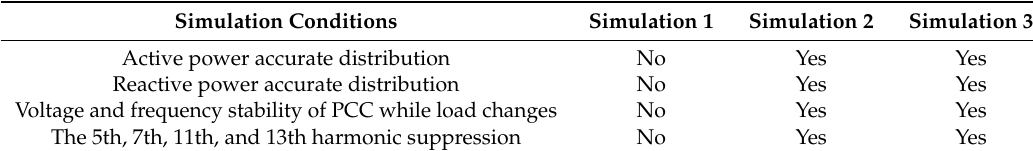
Table 3. The contrast effects of different control strategy simulations.